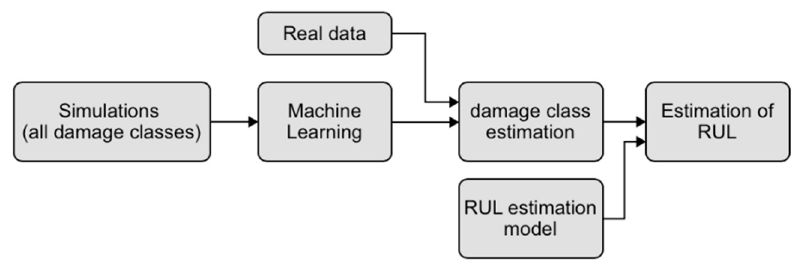
Figure 1. General framework investigated.